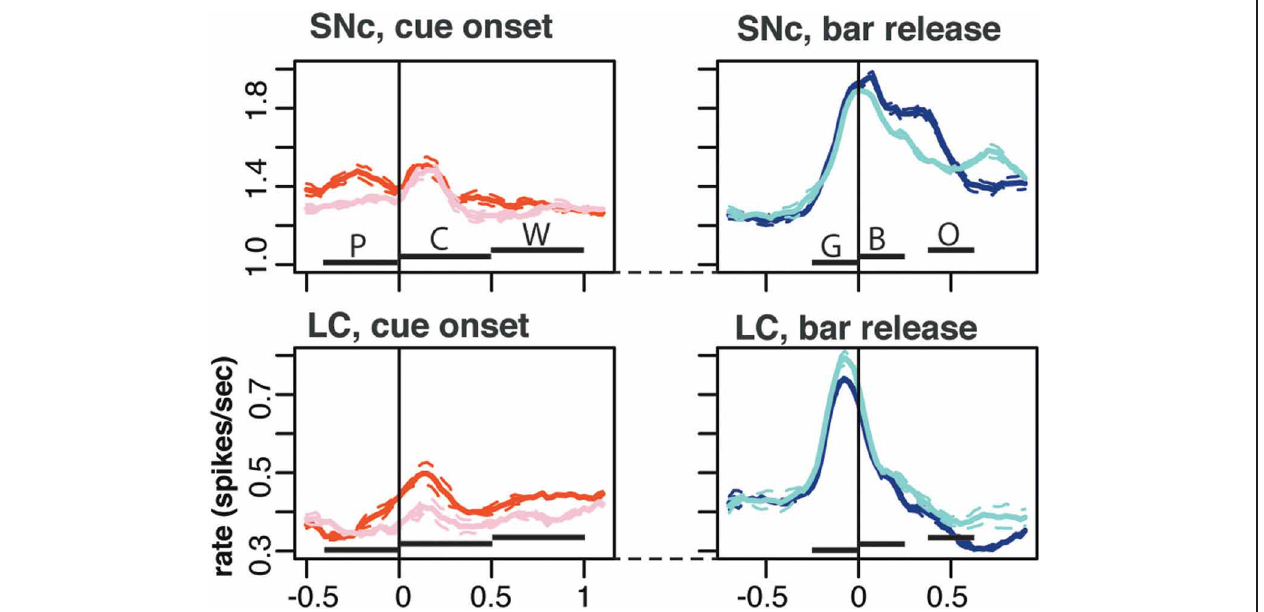
there is a variable period at the end of the wait, followed by the go, blue, and outcome that are also almost completely time-locked (there is a 250ms of jitter in outcome timing). Around bar release (right), we separated rewarded and unrewarded trials. Each trace was generated by averaging firing rates across all recorded neurons in the corresponding subset of trials. The broken lines represent the error (SEM) envelop around the mean. The baseline rates were so similar in general that no normalization of firing rates across neurons was used. On average, the firing of both SNc neurons was greater in first trials around cue onset. Around bar release, the average firing was greater in rewarded trials for SNc neurons but greater in unrewarded trials for the population of LC neurons.